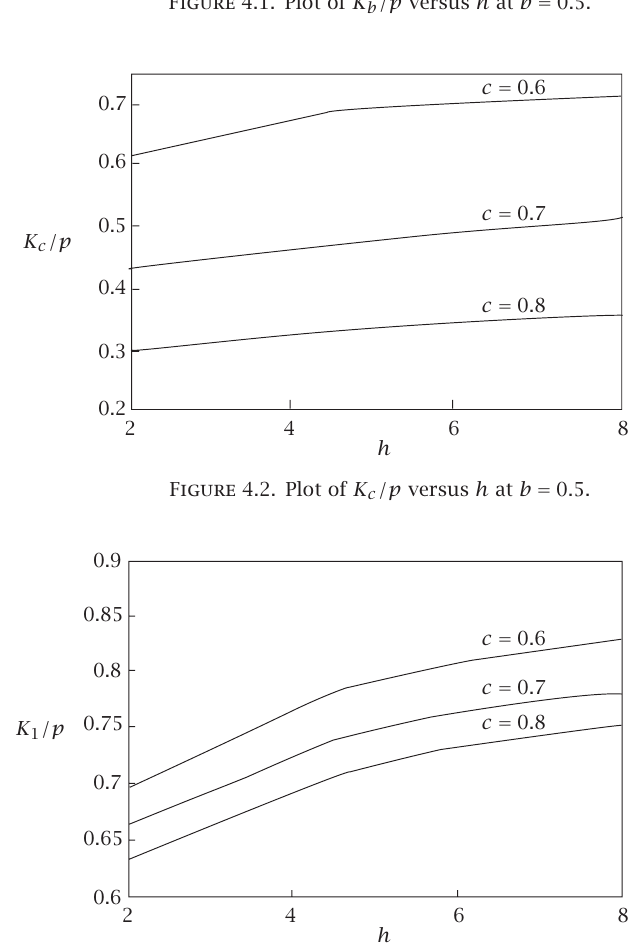
Figure 4.3 . Plot of K